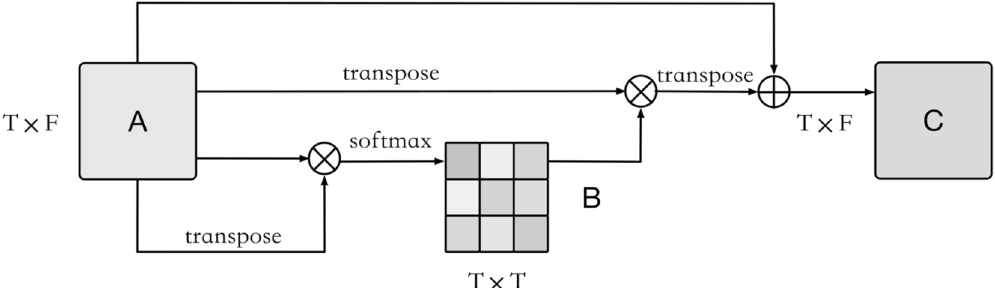
Figure 5. DMAttention